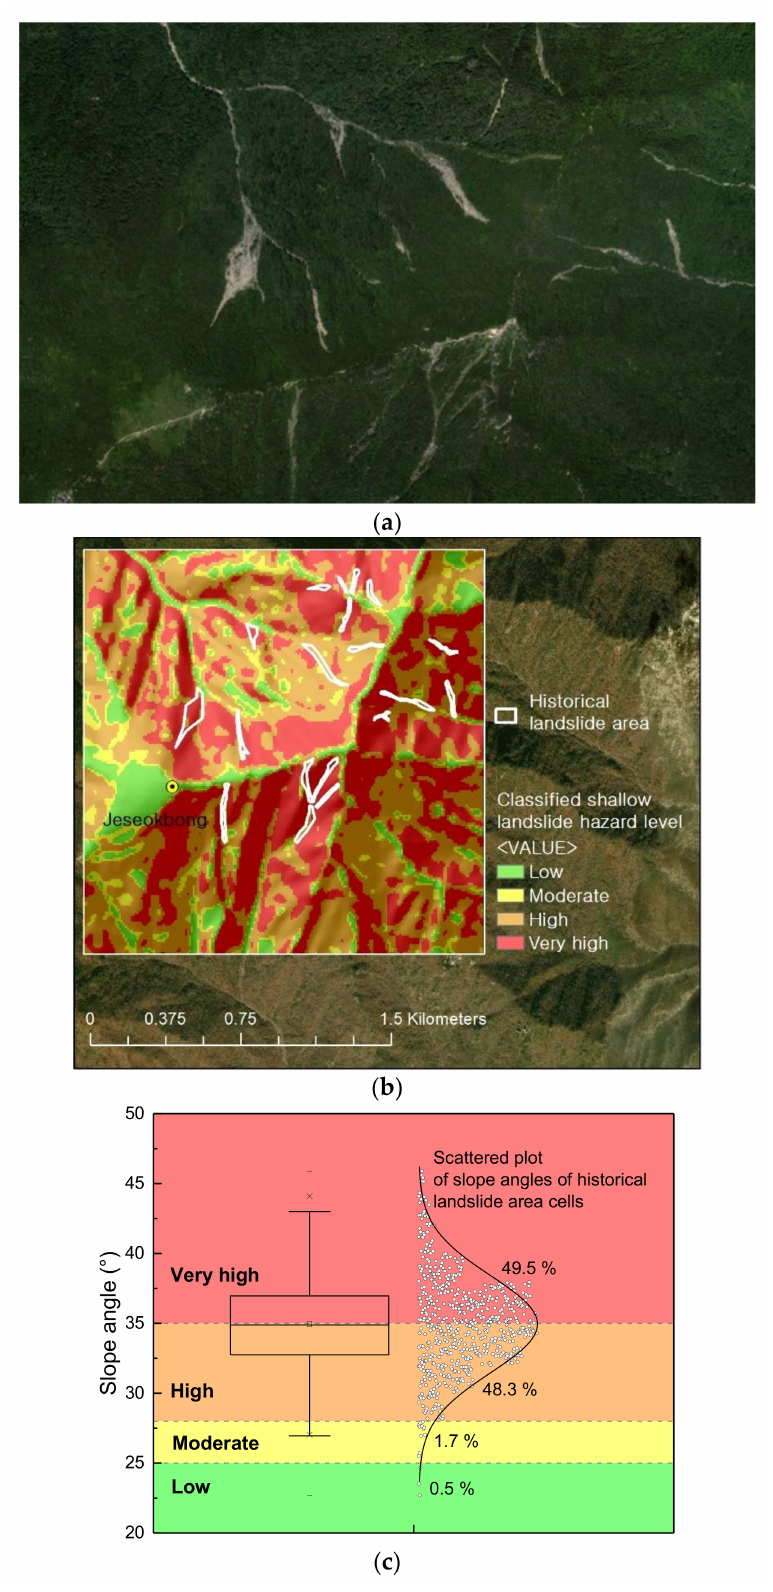
Figure 17. Evaluation results of the landslide hazard levels of the analysis domain area: ( a ) Historical landslide areas in the domain area (satellite image taken in 2018); ( b ) Spatially classified landslide hazard mapping; ( c ) Landslide hazard class distribution of the historical landslide